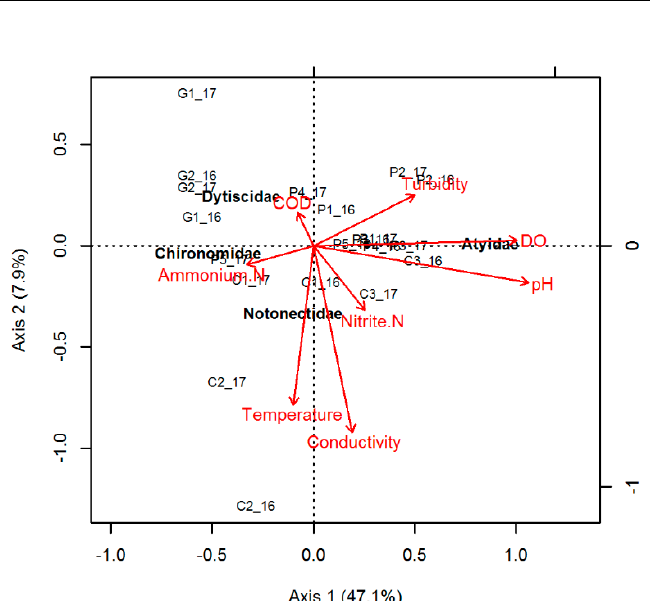
Figure 3. Redundancy analysis (RDA) of freshwater sites at San Crist ó bal island (Galapagos). The first axis was found to be statistically significant according to a permutation ANOVA test ( p = 0.004). The data represent 10 sites within three separate basins (P, C, and G) from two consecutive years (2016 and 2017).